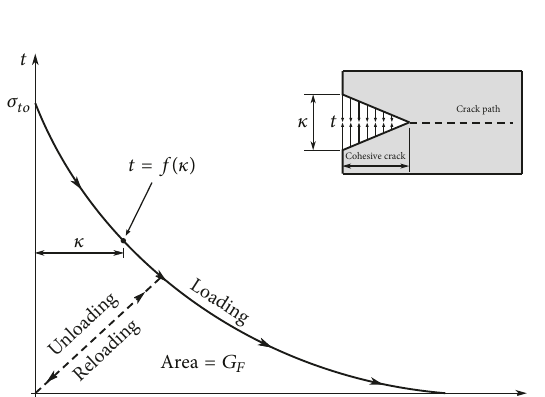
Figure 4: Finite element with internal crack.